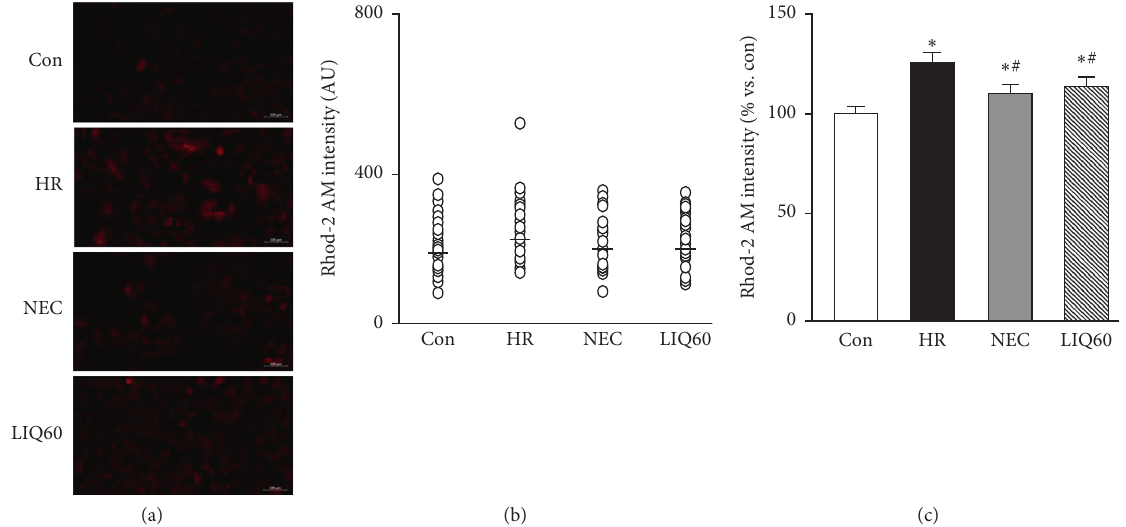
Figure 6: Mitochondrial calcium level in H9C2 cells subjected to different treatments. (a) Representative images of H9C2 cells stained with Rhod-2 AM. (b) The graph indicates fluorescence intensity per cell ( ○ , open circle) of the representative images. (c) The graph indicates the total Rhod-2 AM intensity; AU: arbitrary unit; Con: normal control; HR: hypoxia/reoxygenation; NEC: HR+NecroX-5; LIQ60: HR +LIQ at a dose of 60 μ M; ∗ p < 0 . 05 vs. Con; # p < 0 . 05 vs. HR; n � 3; scale bar 100 μ